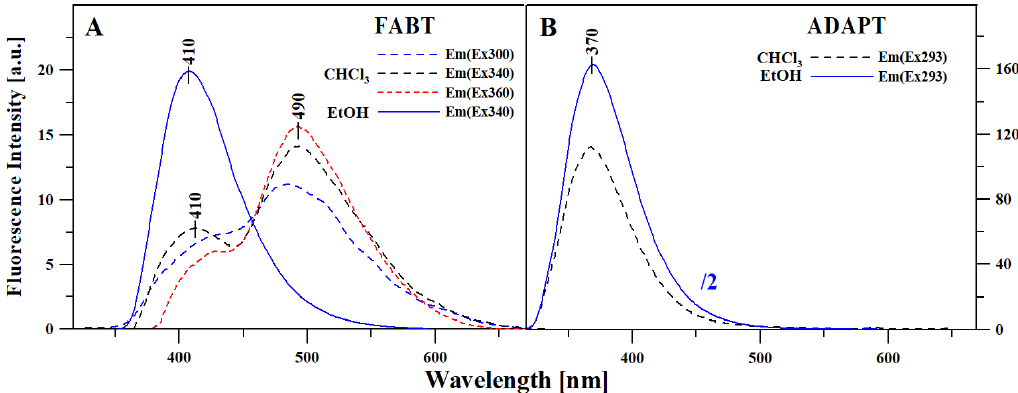
Figure 2. Fluorescence emission spectra for FABT (Panel ( A )) and ADAPT (Panel ( B )) in ethanol and chloroform. The excitation is pointed out in the figure for each sample.